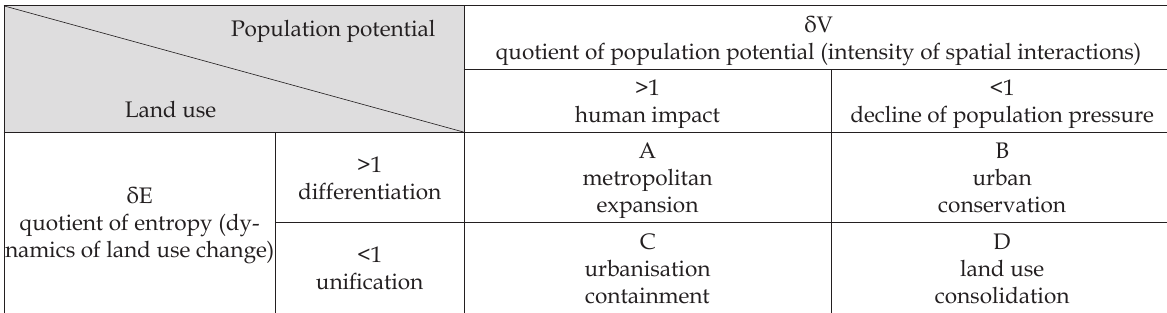
Table 1. Comparison of theoretical values of spatial-temporal quotients of entropy of land use and quotients of spatial interactions (population potentials, see explanation in text)